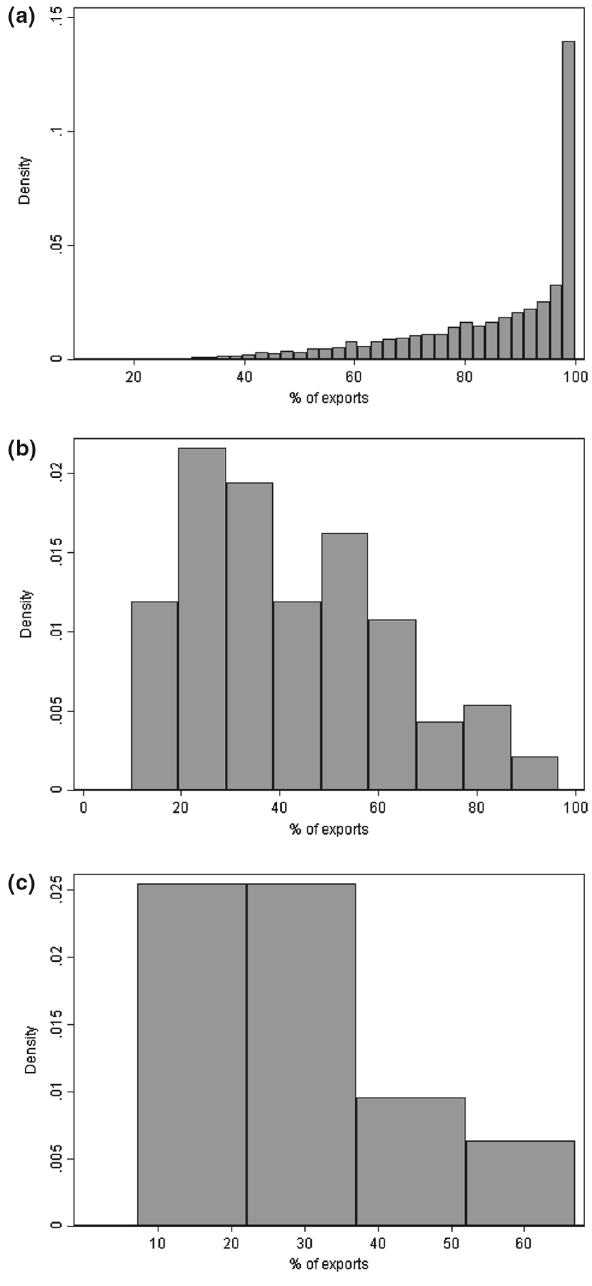
Fig. 3 Concentration of exports in the top 5 firms across products, 2015 a CN 8-digit classification (7560 products) b Export chapters (96 chapters) c Export sections (21 sections). Source: Own calculations, based on the Customs